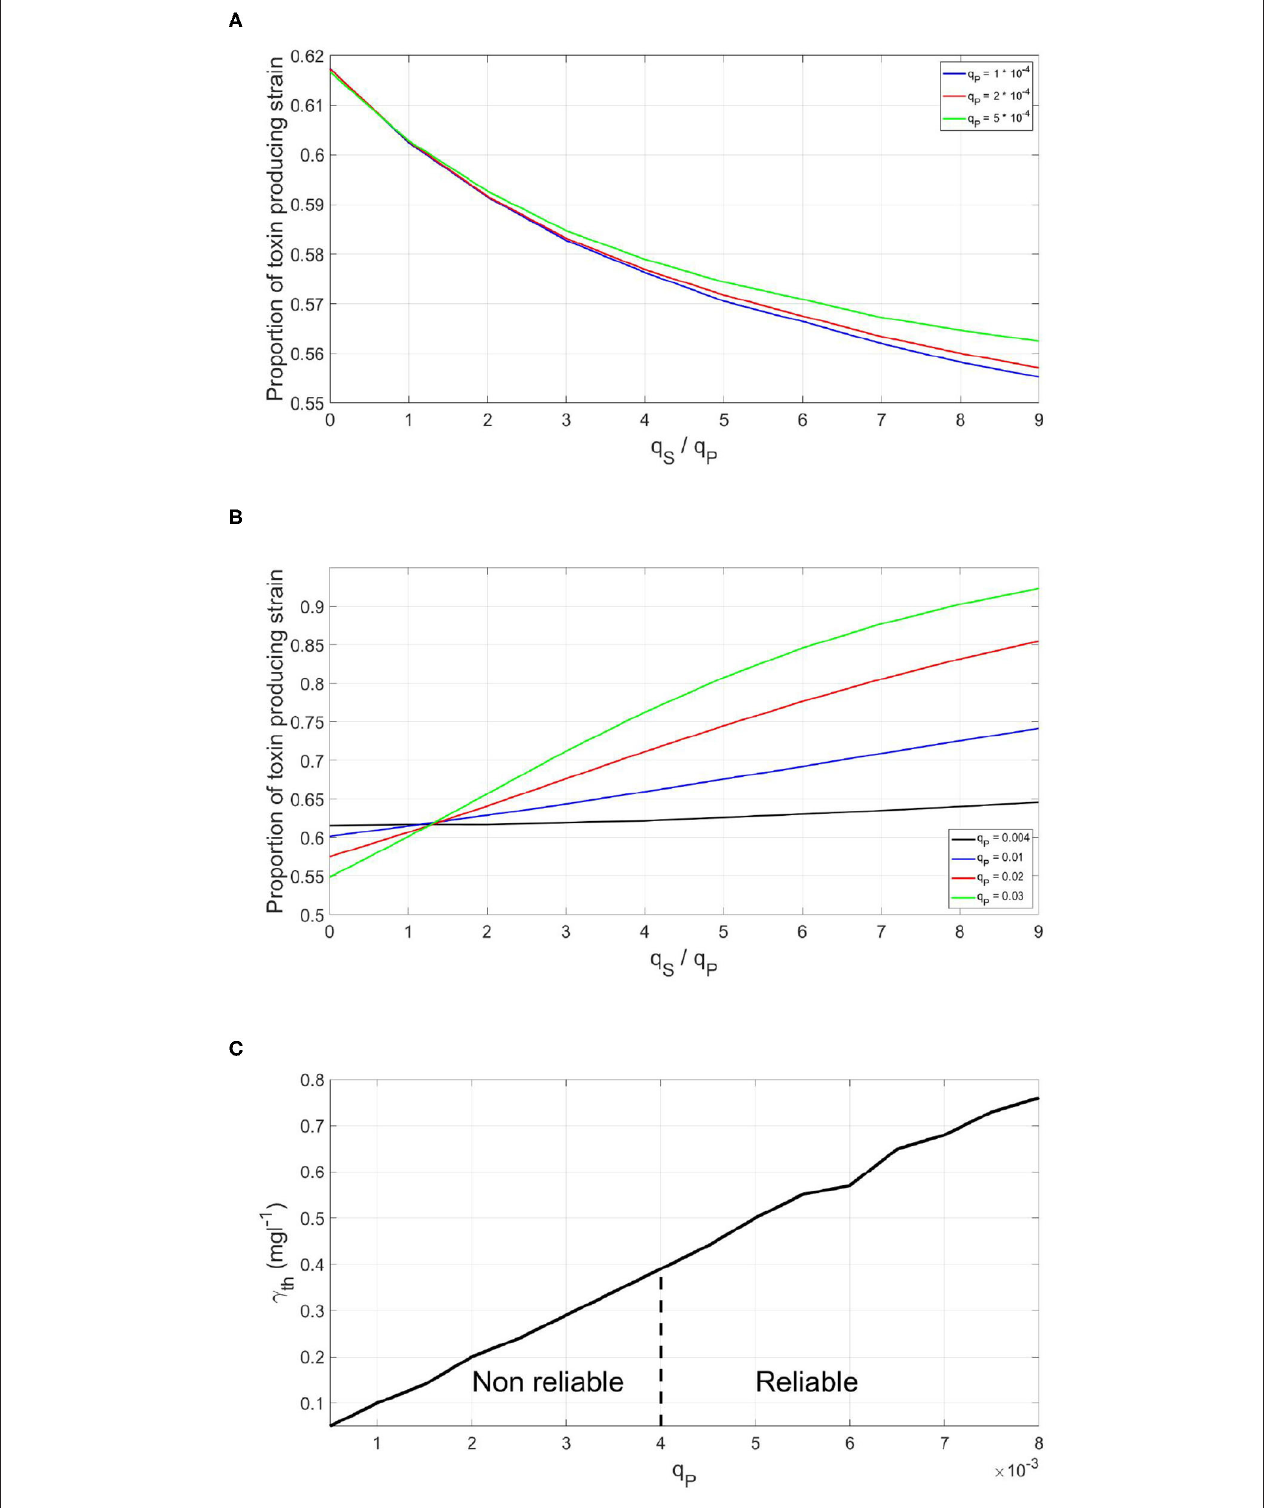
FIGURE 4 | The effect of the metabolic cost of a QS regulation system on its reliability when the focal QS bacteria is in a competition with a dishonest signals producer. (A) The final fitness of a focal QS strain under different levels of dishonest signals production by the sensitive strain, when the QS regulation system of